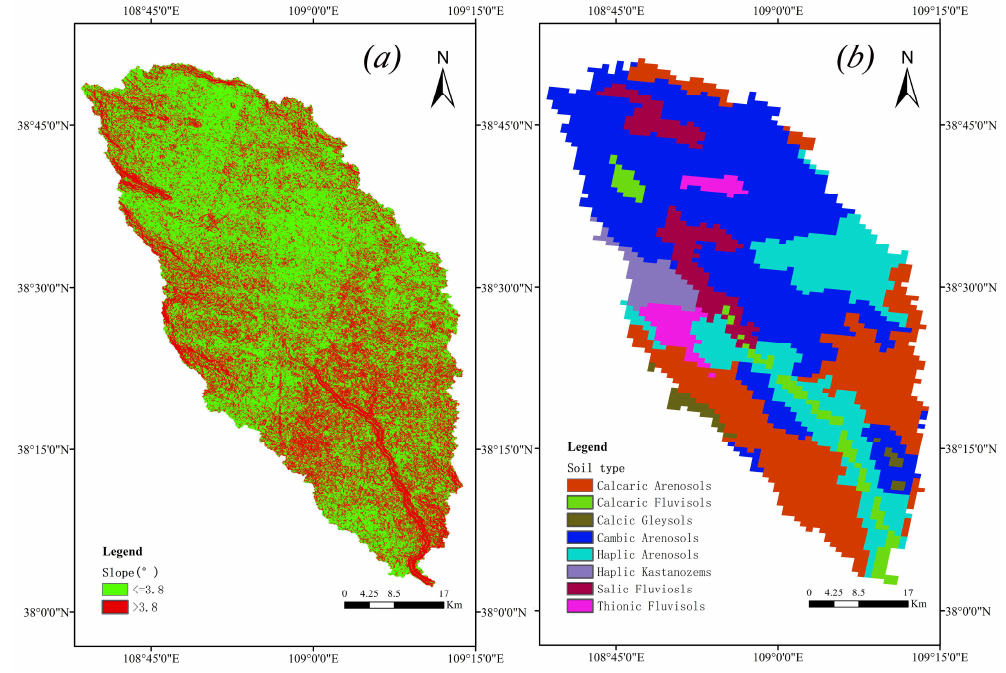
Figure 2. The ( a ) slope classes and ( b ) soil types of the Hailiutu River basin.